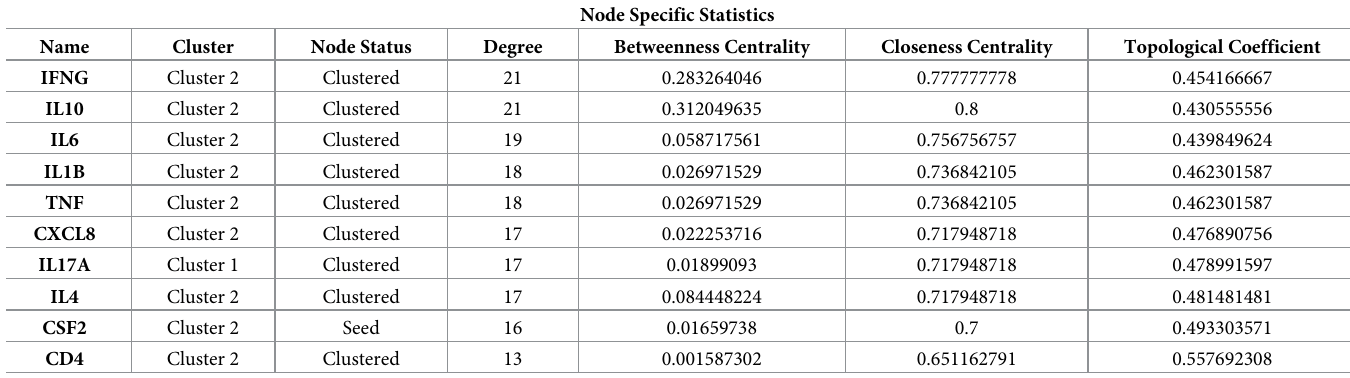
Table 5. Node specific statistics of network analyzer, given topological parameters for each hub gene.